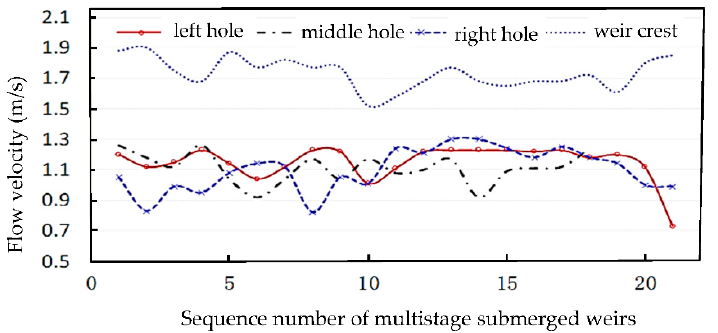
Figure 22. Change process of the flow velocity along the transition reach in Case S 2 . The velocities of the weir flow at the upper layer and the bottom orifice flow both fluctuated along the reach in the range of 0.4 to 0.6 m/s. The upper velocity in Case S 2 was decreased by 0.25 to 0.85 m/s compared to that in Case S 1 . Therefore, the layer conditions of the flow structures and their flow intensities are both suitable for migrating fish and also contribute to living aquatic plants, reoxygenation, and improved water ecology.